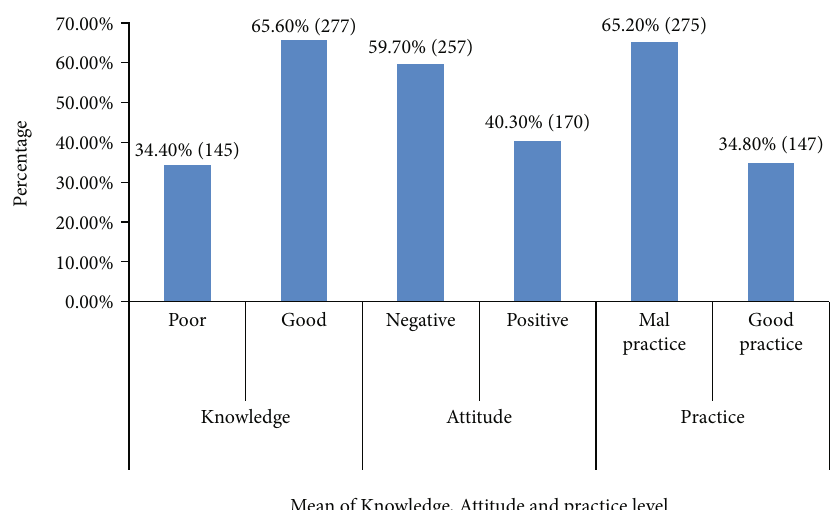
Figure 1: Mean KAP levels of the respondents about HBV early detection, transmission, and